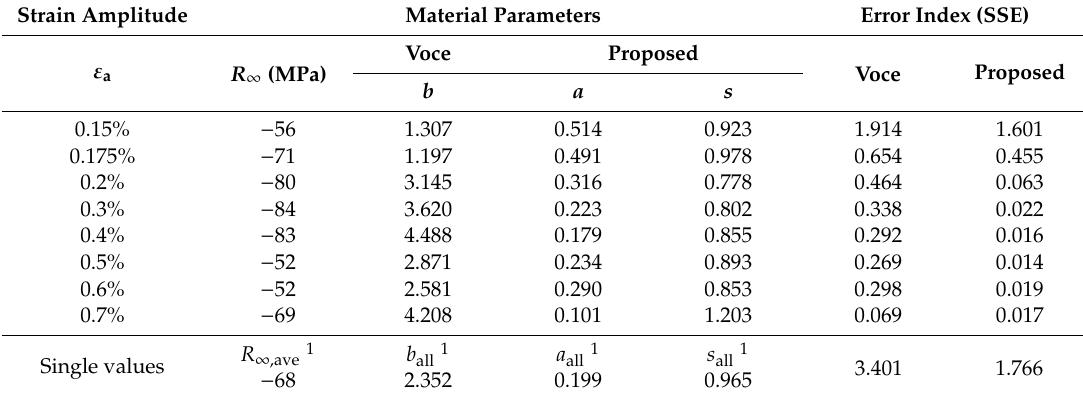
Table 1. Isotropic parameters identified from experimental data for the Voce and proposed models. Goodness-of-fit examined in terms of sum of squares of residuals (SSE) for each model and strain amplitude.